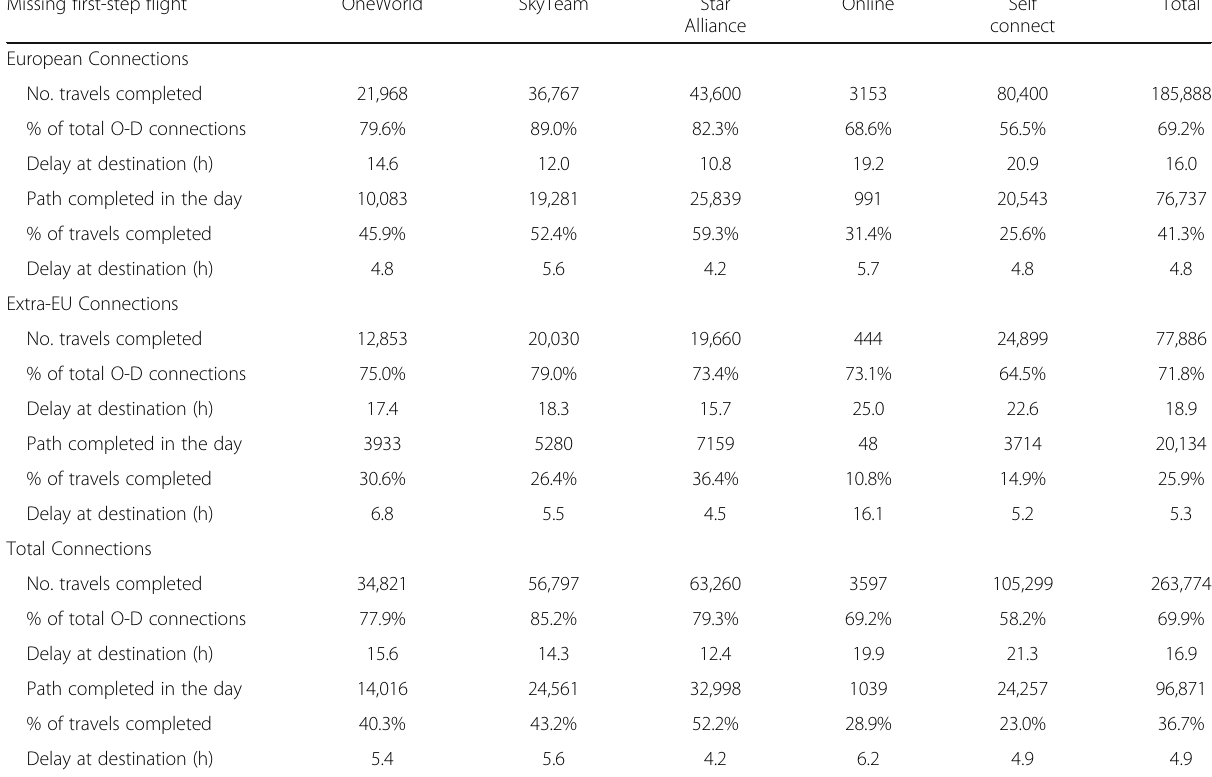
Table 8 Number of travels completed and delay at destination in case of missed the first-leg flight by connection type and geographical regions Missing first-step